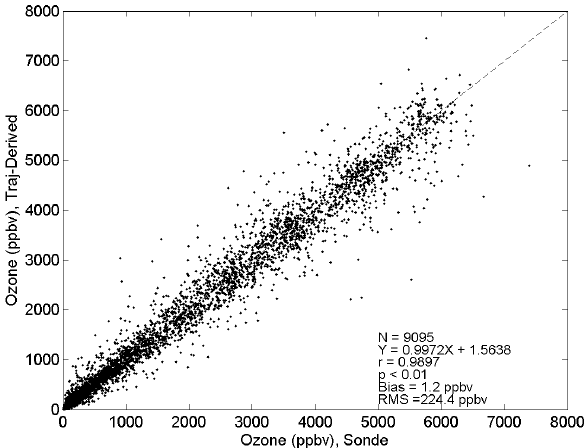
Fig. 3. Correlation ( r ) between ozone mixing ratios from ozonesondes and from trajectories, without input of the stations being tested, for 20 stations in the 1990s and the 2000s. The dashed line shows the 1:1 axis. The correlation is significant at the 1% level ( p<0.01 ). N denotes the number of data points and RMS the root mean square error. Y represents trajectory-derived ozone mixing ratio and X ozone mixing ratio from ozonesondes.